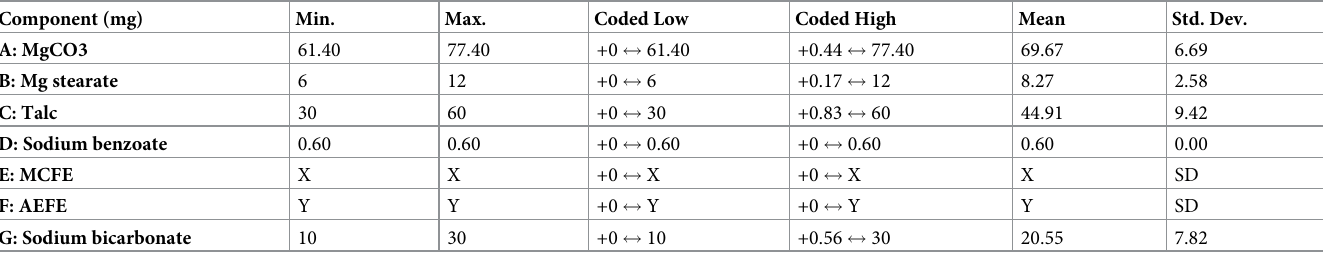
Table 3. Actual and coded design constraints for the herbal capsule formulation. Component